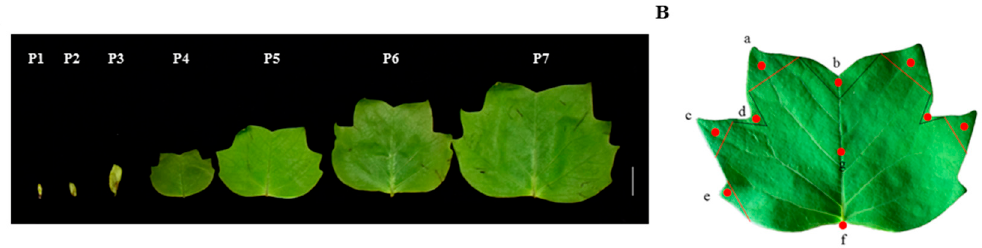
Figure 9. Schematic diagram of sampling in L. tulipifera . ( A ) Different stages of leaf development in L. tulipifera . P1–P2: leaf bud growth stage; P3: young leaf stage; P4–P6: mature stage; P7: senescence stage; ( B ) Different parts of leaf in L. tulipifera , a, c, and e: leaf tooth tip, b and d: leaf tooth sinus, g: middle of leaf, f: petiole.